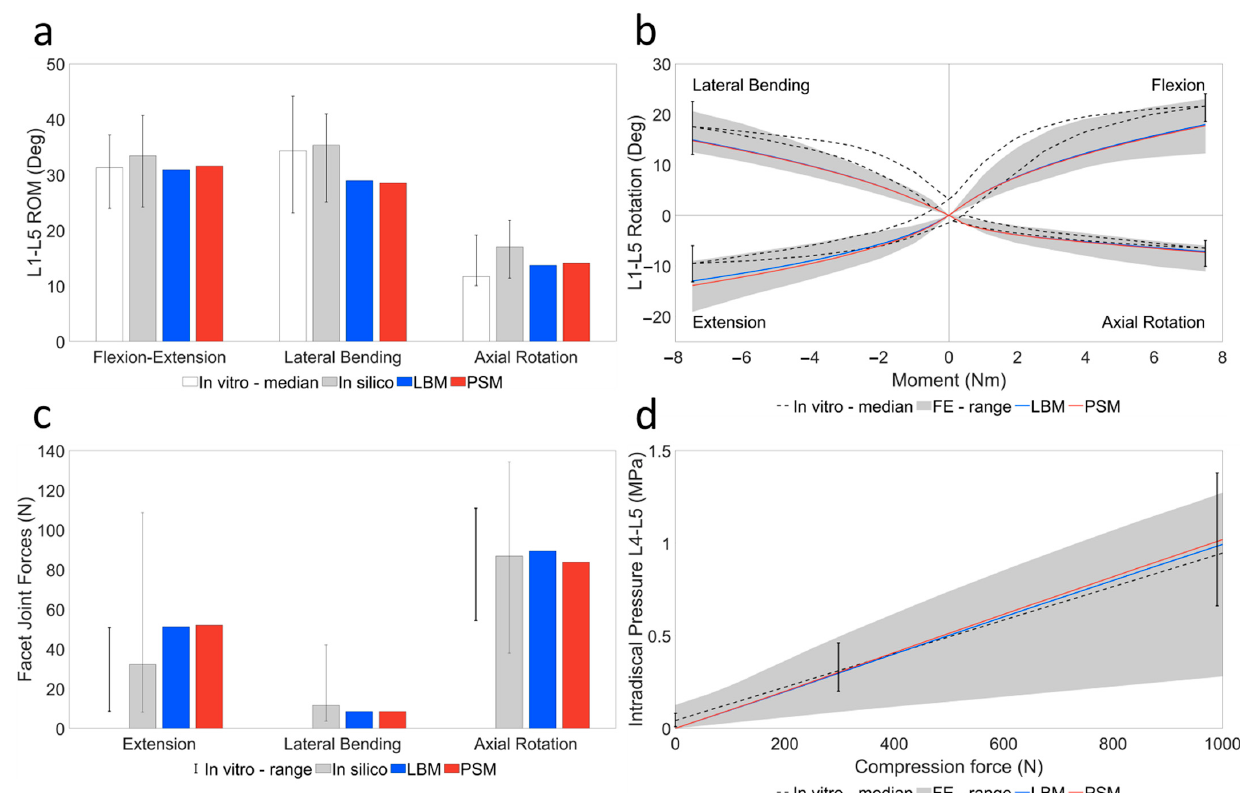
Figure 3. Results of the FE models against pure bending of 7.5 Nm. ( a ) Predicted total ROM values in flexion-extension, lateral bending, and axial rotation for the LBM and LSP models. The white bars and their ranges correspond to the median and the range of an in vitro measurement [57]. The grey bars and their range represent the median and the range of multiple published FE results [2]. ( b ) Load-deflection curves of the LBM and PSM. The median results of an in vitro experiment are shown with a black dashed line, while the black error bars represent the range of results at 7.5 Nm [57]. The minimum and maximum values of the in silico results are shown as a grey band [2]. ( c ) The mean FJF values at all spinal levels for the LBM and the LSP models. The black error bars correspond to the range of facet joint forces measured in vitro [58]. The grey bars and their ranges show the median, the minimum, and maximum values of the in silico results [2]. ( d ) IDP values of the nucleus pulposus at L4–L5 against compressive follower load for both FE models. The black dashed line shows the median result of an in vitro measurement, while the black error bars represent the minimum and maximum values for 0 N, 300 N, and 1000 N [59]. The range of validated FE results is shown as a grey band